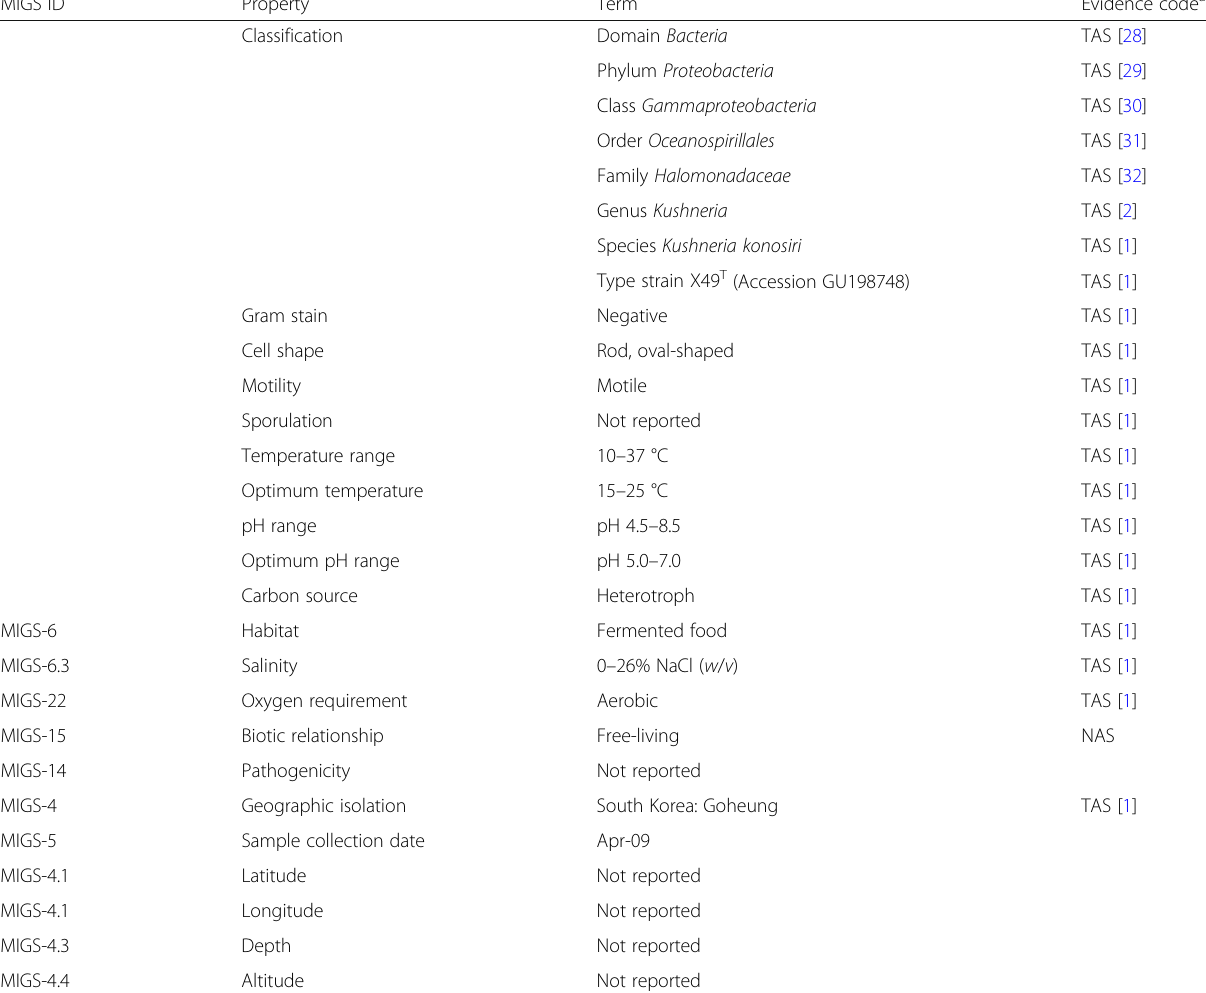
Table 1 Classification and general features of K. konosiri X49 T according to the Minimum Information about a Genome Sequence (MIGS)